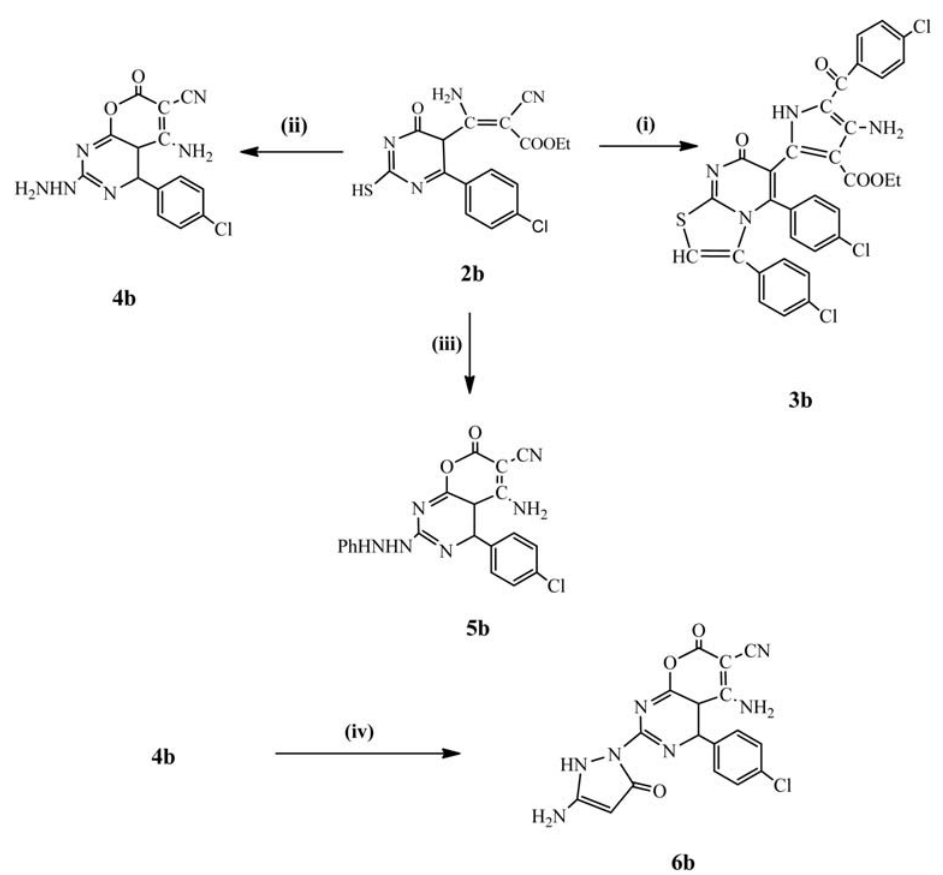
Scheme 2 . Reactions of 4,5-dihydropyrimidine 2b and reaction of 4b with ethyl cyanoacetate. Reagents and conditions; (i) 4-ClC solute EtOH,